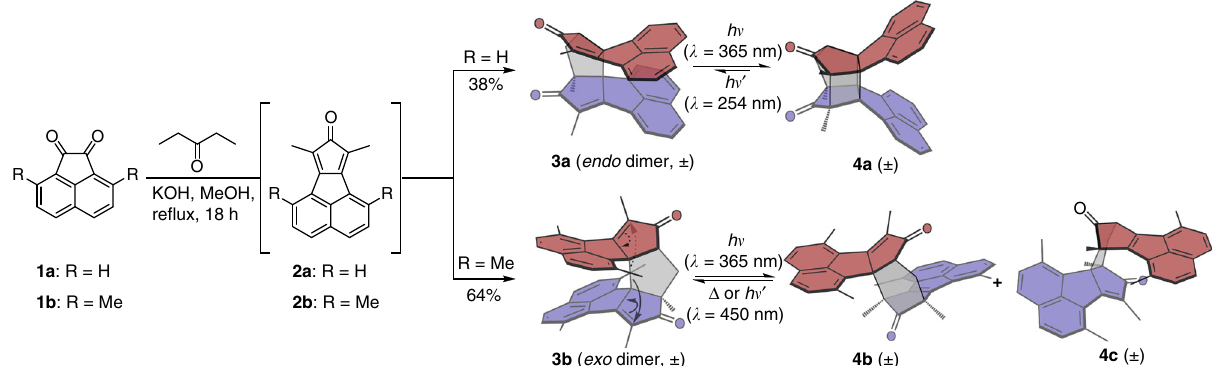
Fig. 1 One-pot synthesis and photochemical reactions of 3a and 3b . Both 3a and 3b are obtained as a pair of enantiomers. The photochemical rearrangements of 3b leading to 4b and 4c are indicated by solid and dashed arrows, respectively. NATURE COMMUNICATIONS| (2019) 10:5480